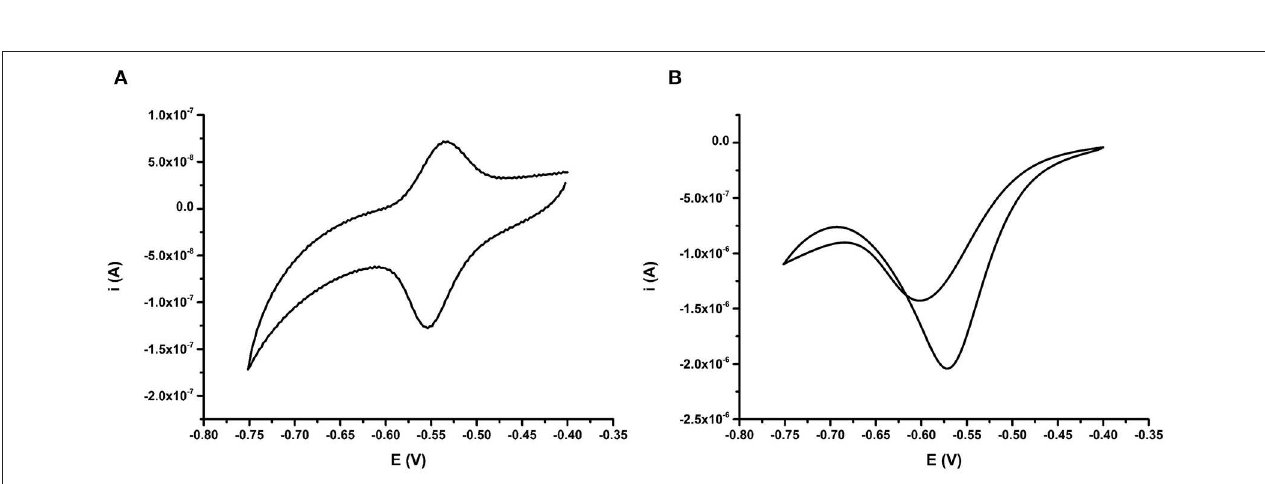
FIGURE 2 | (A) Behavior of AQ probe BA-1 deoxygenated (oxygen purged) conditions achieved by purging the electrolyte with argon for 30min, and (B) oxygenated (oxygen present) conditions. Electrochemical scans are representative of n = 3 repeat electrodes, and were performed at 50mV s − 1 vs. SCE.